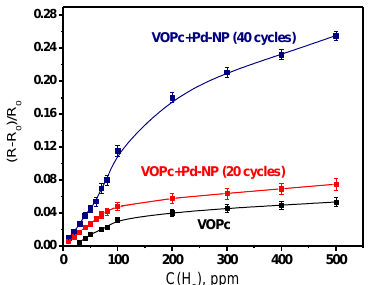
Figure 9. Dependence of the sensor response of a VOPc film and VOPc films covered with Pd nanoparticles during 20 and 40 cycles of pulse-CVD on hydrogen concentration.